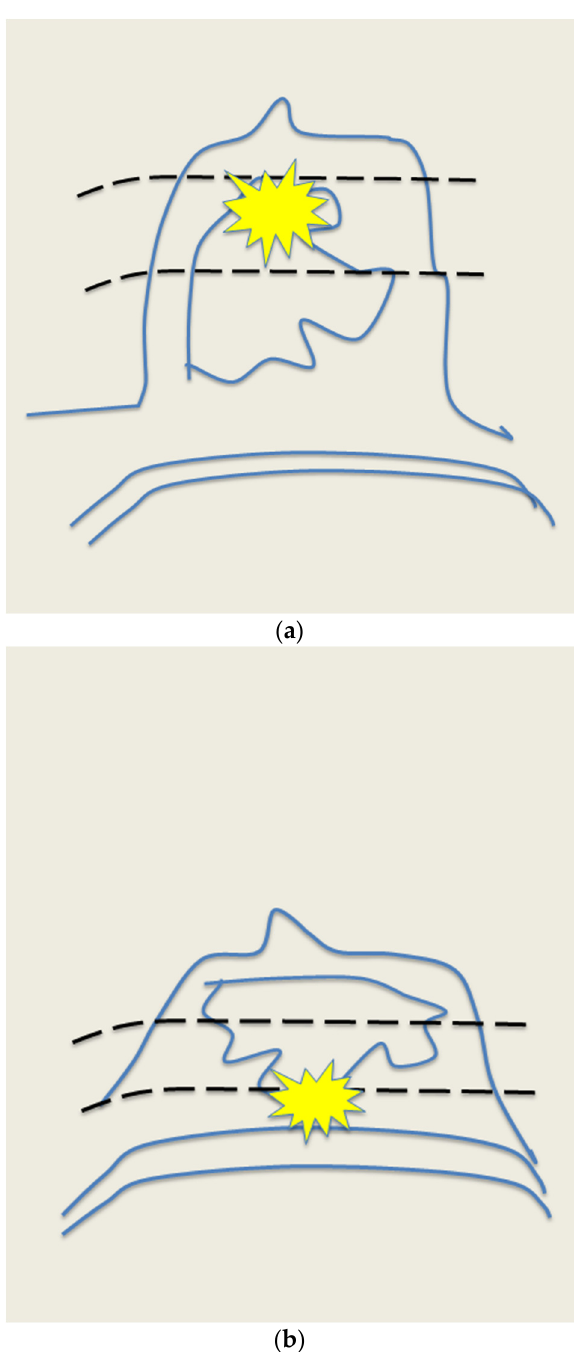
Figure 15. Example of position varying between mammogram ( a ) and US ( b ).